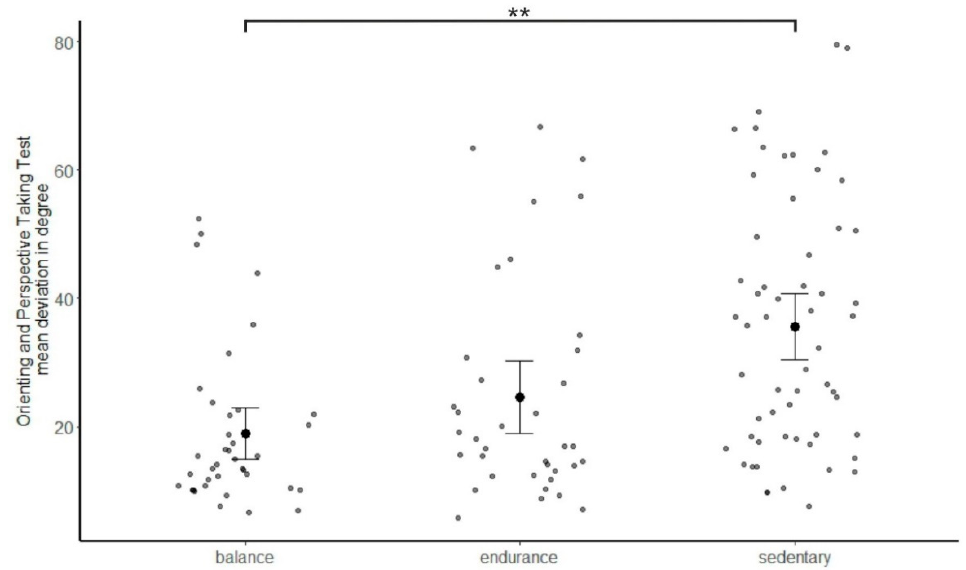
Figure 2. Mean deviation error in the Orienting and Perspective Taking Test, separately for the balance experts, endurance athletes and sedentary participants. Error bars indicate 95% confidence intervals. Data of single participants are plotted in grey. ** p < 0.01, post hoc contrast.